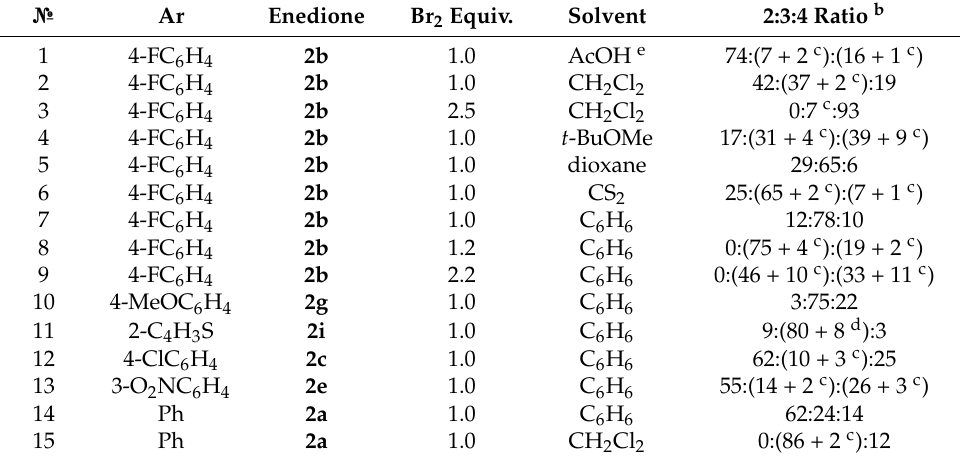
Table 2. Selectivity of bromination of enediones 2 a